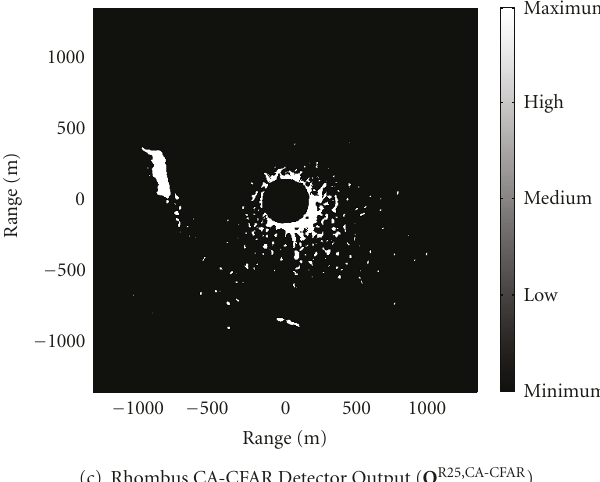
Figure 7: Radar Images Processed by the CA-CFAR Detection System Using its Best H, V, and R Integration Modes.